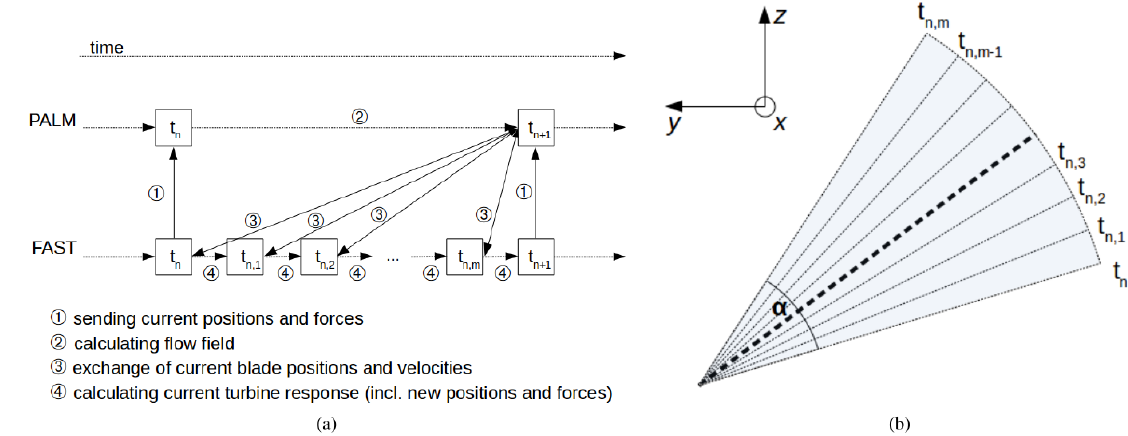
Figure 1. Schematic of the operation mode of the PALM–FAST ASM coupling. (a) Schematic of the PALM and FAST time stepping. (b) Schematic of one circle segment of the ASM. The values of the bold central line are used for the projection of the forces into the flow. Here, y and z denote the rotor plane and x the streamwise